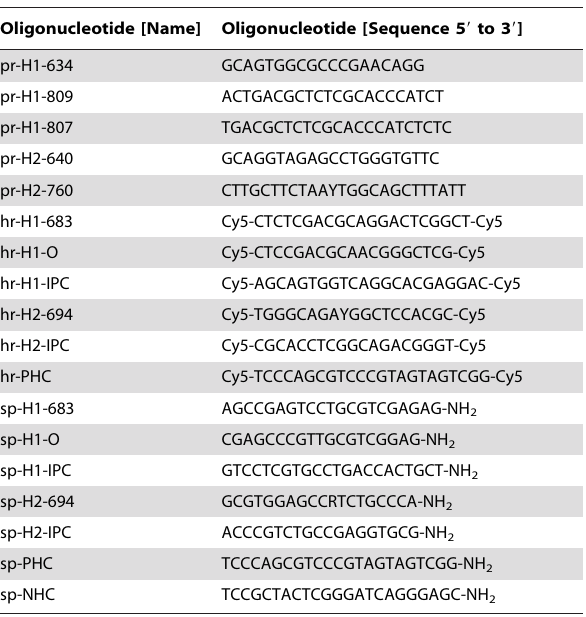
Table 2. Oligonucleotide sequences of the primers, reporter probes and immobilized capture